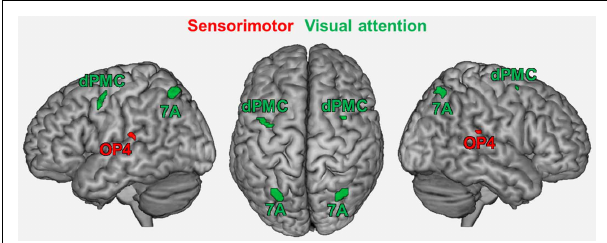
FIGURE 1 | Regions showing an age by task interaction as reported in a previous study (Roski et al., 2013). These regions represent the fMRI-based seed regions for the present study. Green color denotes regions associated with visual attention; red color denotes regions associated with sensorimotor processing. 7A, superior parietal lobule area 7A (cytoarchitectonically defined; Scheperjans et al., 2008a,b); dPMC, dorsal premotor cortex; OP4, area OP4 of the parietal operculum (cytoarchitectonically defined; Eickhoff et al.,